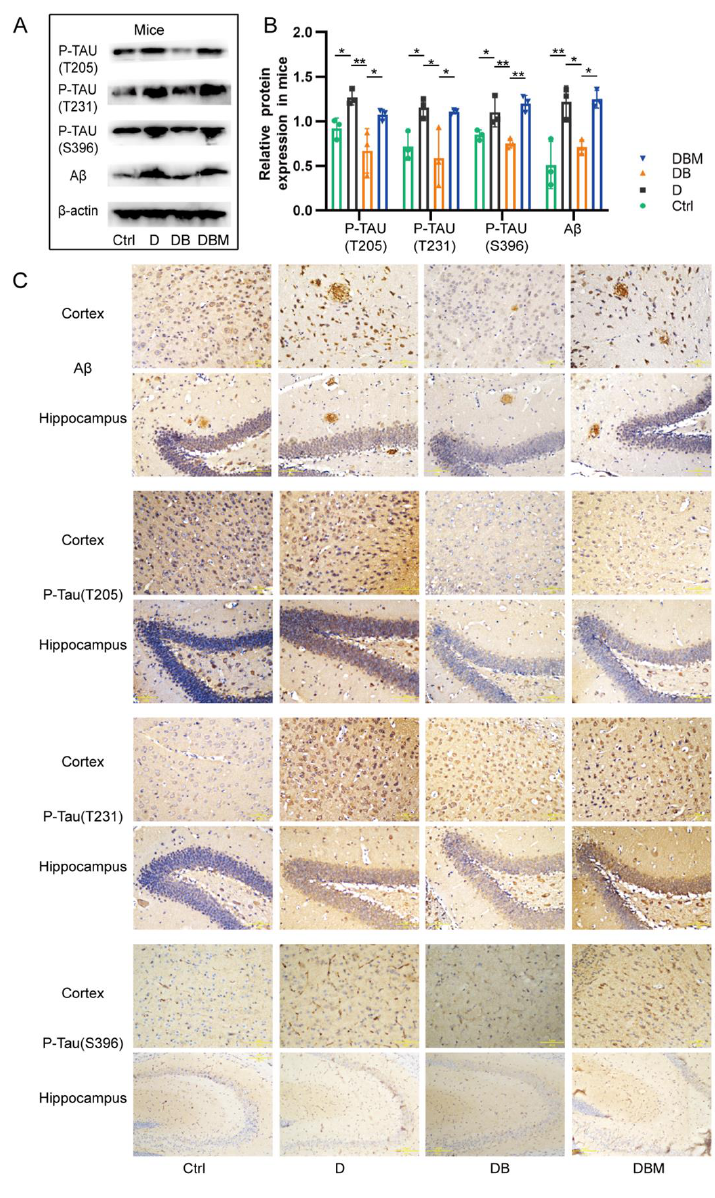
Figure 4. Berberine mitigated Alzheimer’s pathology induced by D-ribose by promoting mitophagy. The expression of A β , P-TAU (T205), P-TAU (T231) and P-TAU (S396) in the hippocampus and cortex of APP/PS1 mice in the D group was significantly increased compared with the control group ( A ). The results of immunohistochemical staining also showed the same effect ( B ). Representative Western blot images and bar graph of p-Tau and A β in the cortex and hippocampus of APP/PS1 mice ( A , B ). Representative images of immunohistochemistry of p-Tau and A β on sections of cortex and hippocampus ( C ). A β , p-Tau (T205), p-Tau (T231), scale bar = 5 µ m. p-Tau (S396), scale bar = 10 µ m. * p < 0.05, ** p < 0.01. Abbreviation: A β , β -amyloid; p-Tau (T205), phosphorylated T205 tau; p-Tau (T231), phosphorylated T231 tau; p-Tau (S396), phosphorylated S396 tau. Ctrl, Control; D, D-ribose; DB, D-ribose + BBR; DBM, D-ribose + BBR +